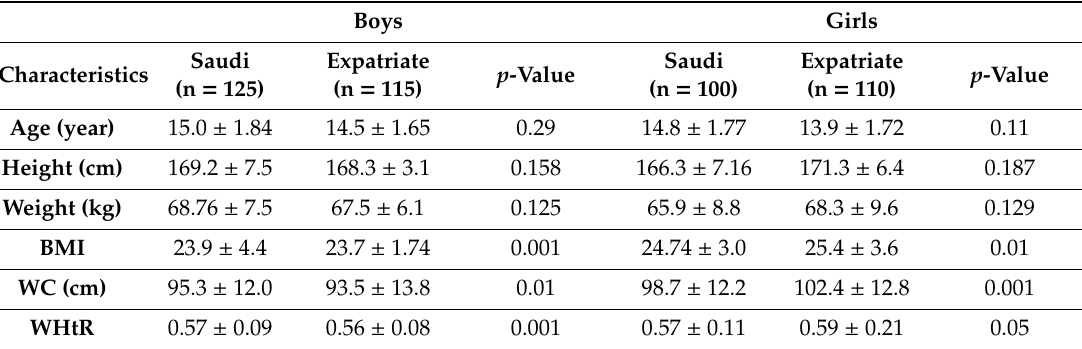
Table 1. Demographic and anthropometric data of participants: Mean ± SD (n = 450).